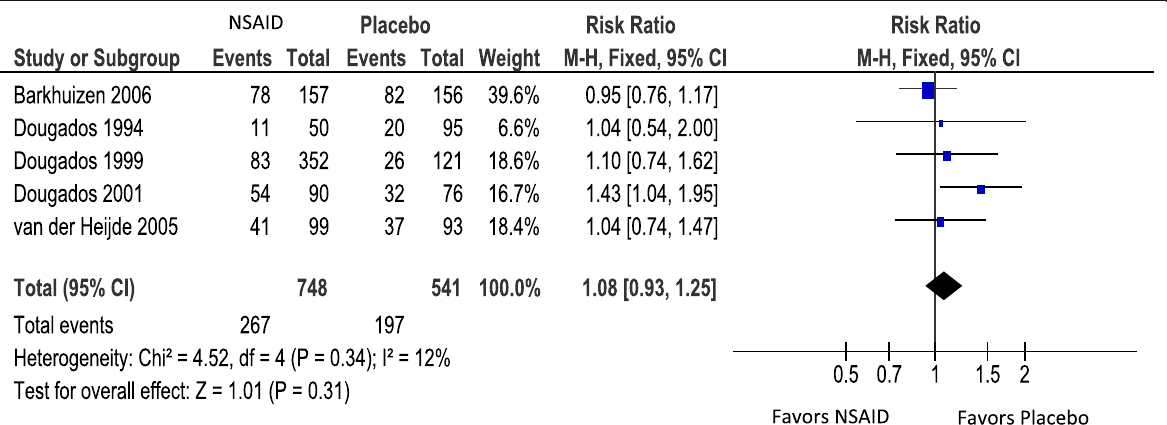
Fig. 5 Incidence of any adverse events in the comparison of traditional NSAIDs versus placebo in patients with ankylosing spondylitis: meta-